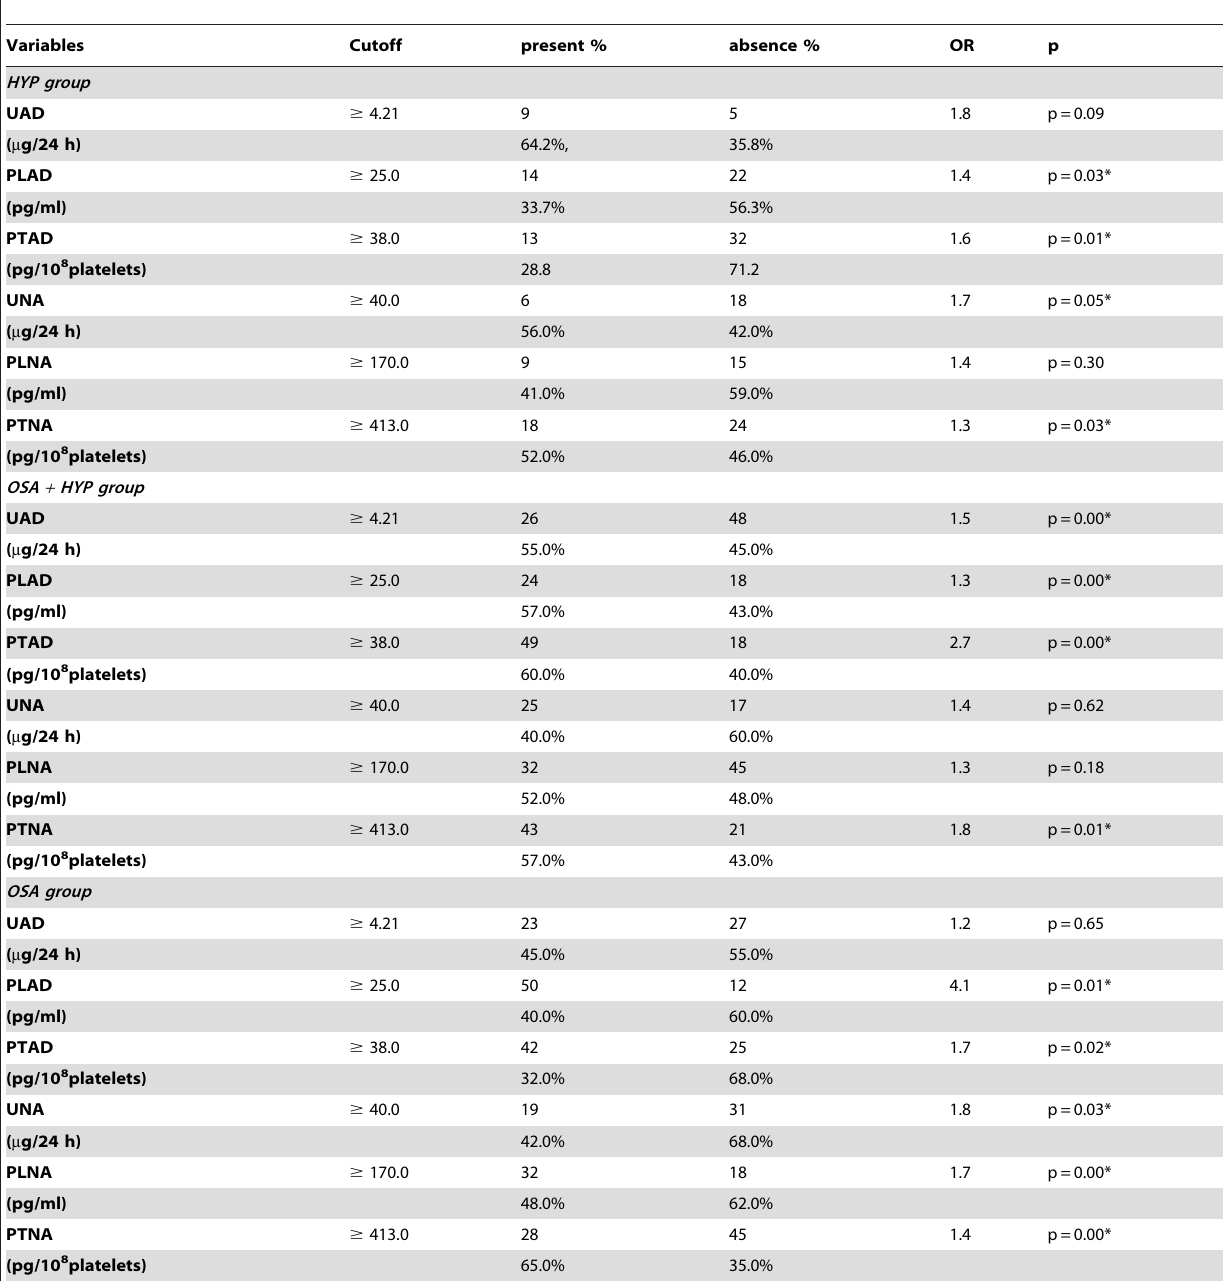
Table 2. Results of the cutoff points obtained by the bootstrap for determination of AD and NA in different biological samples and